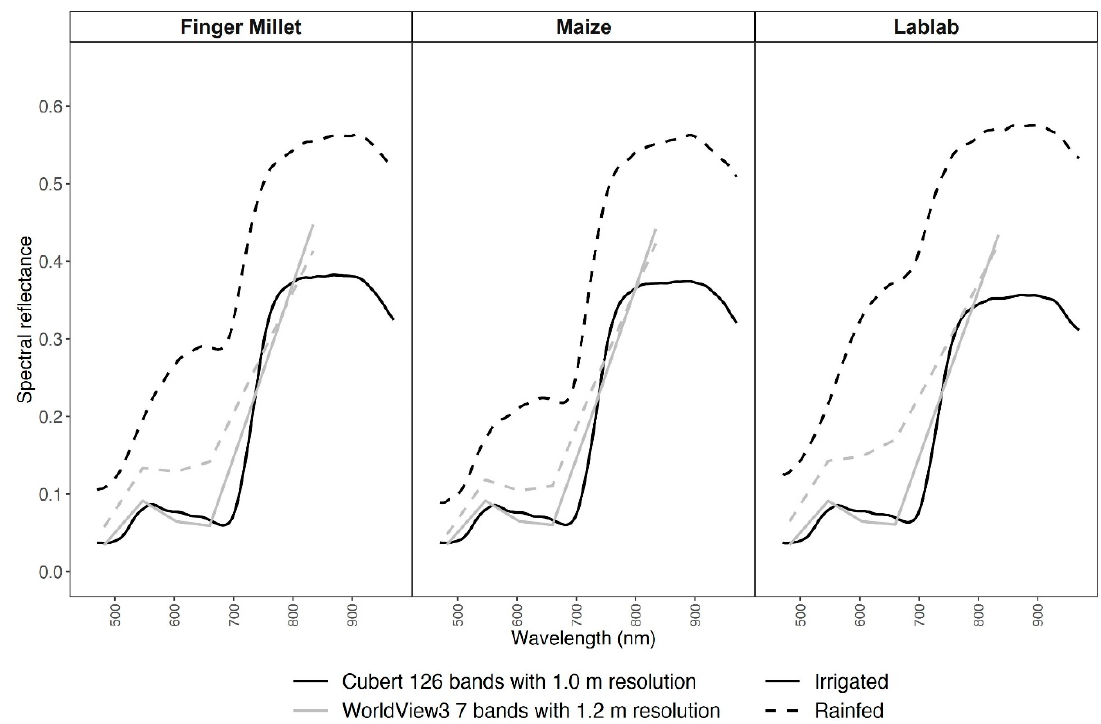
Figure 2. Average spectral reflectance data for millet, lablab, and maize from Cubert (black) and WorldView3 (grey) data for irrigated (solid line) and rainfed (dashed line) experiments.